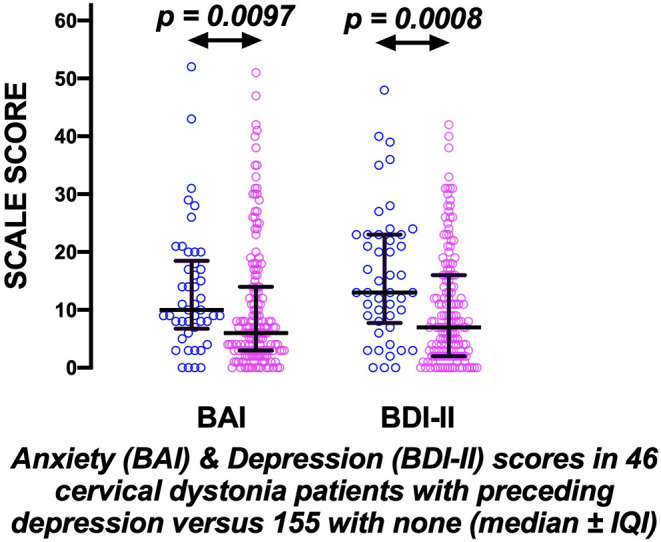
The prolonged effects of preceding mood disorder in cervical dystonia. Evidence of significant persisting anxiety and depression measured by the Beck Anxiety inventory (BAI) and Beck Depression Inventory (BDI-II) scores, ~18 years after disease onset, in 46 cervical dystonia patients (blue circles) with preceding anxiety/depression compared to 155 with none (pink circles) (bars indicate medians ± inter-quartile intervals).